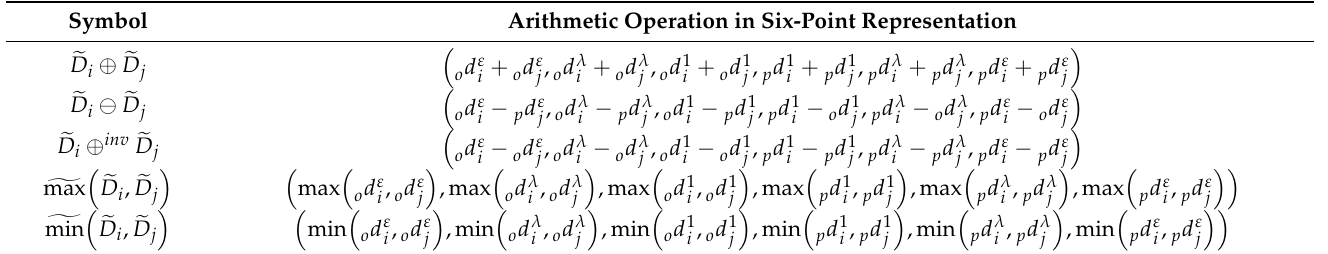
Table 2. Basic arithmetic operations of fuzzy numbers in six-point representation used for time calculations for two fuzzy numbers, representing fuzzy durations of process j and i [26,27]. Symbol Arithmetic Operation in Six-Point